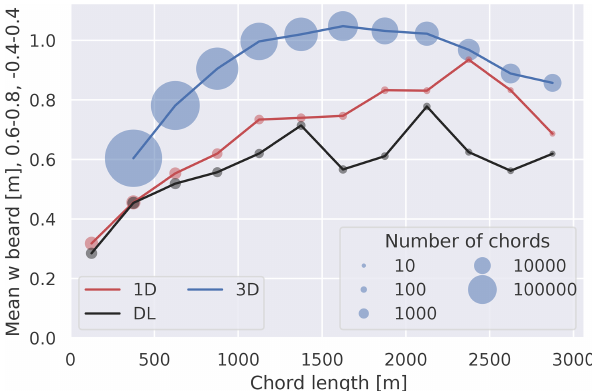
Figure 8. Mean normalized vertical velocity below chord base as a function of chord length. The area over which the vertical velocity is averaged is marked by the grey box in Fig. 9. The size of the markers represents the number of chords in that 250m bin. Note that there is no 3D value for chords below 250m as we only compute scenes for chords with at least 10 data points as explained in Sect.